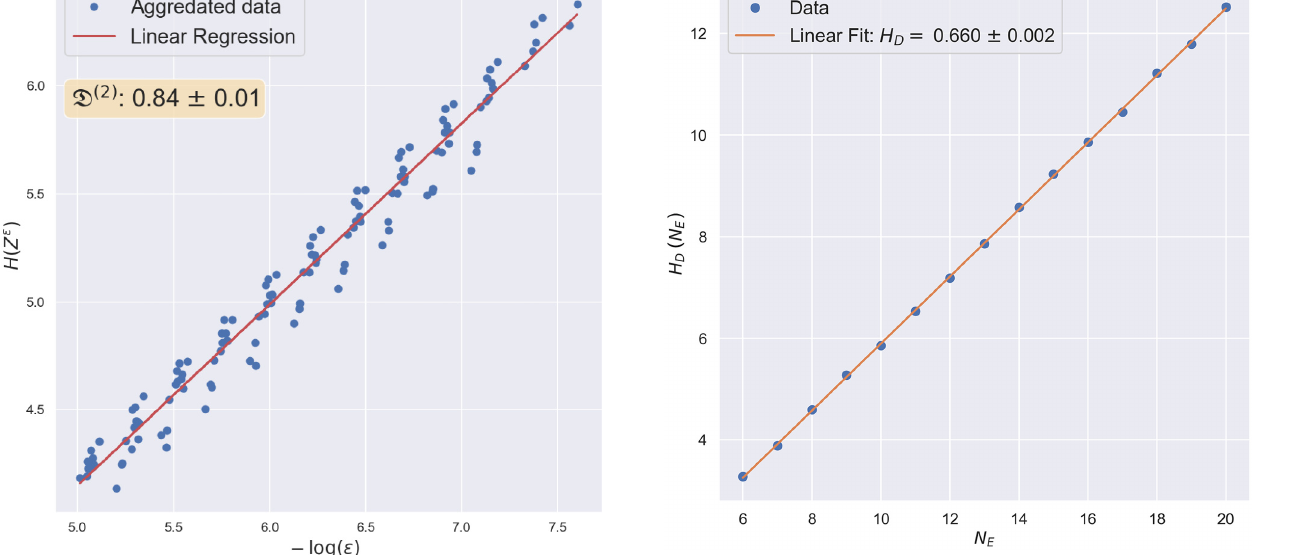
FIG. 12. Information dimension of the same geometric quan- tum state, estimated using aggregated data. To extract the infor- mation dimension in the thermodynamic limit, we do not distin- guish between points belonging to different environment sizes.